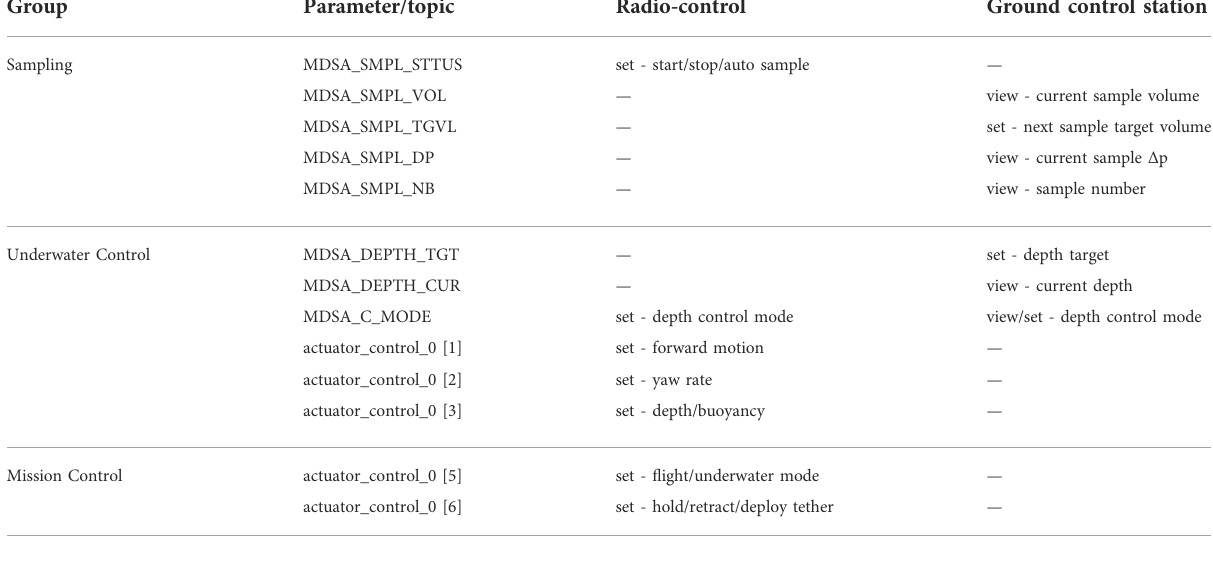
TABLE 2 List of parameters and topics used to handle the underwater locomotion mission section, sampling control, depth control and tether extension/retraction. Group